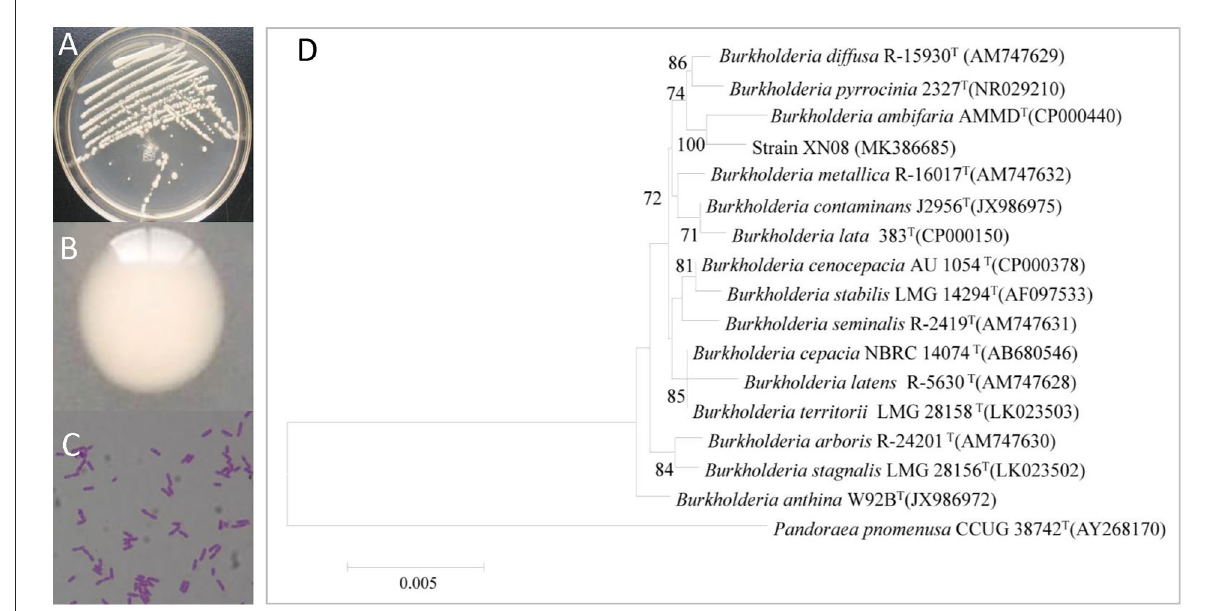
FIGURE1 Morphological and molecular identification of the endophytic bacterium XN08. The colonies (A) , colony characters (B) of the strain XN08 on LB medium and microscopic characters (C) under a light microscope ( × 400), phylogenetic tree of the strain XN08 based on 16S rRNA sequence (D) .